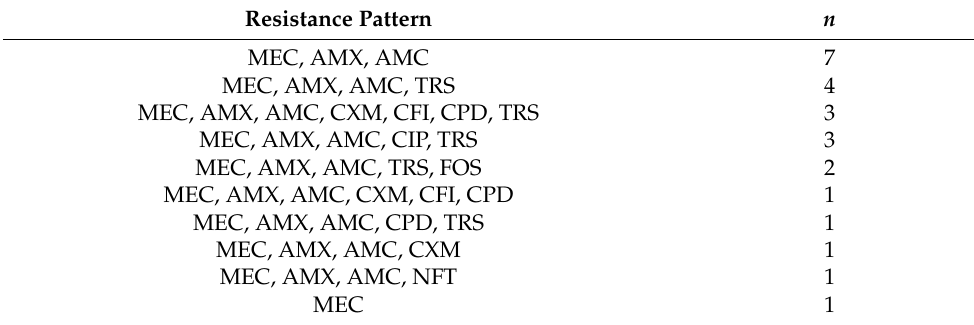
Table 3. Resistance patterns of the 24 mecillinam-resistant E. coli urine isolates. Resistance Pattern